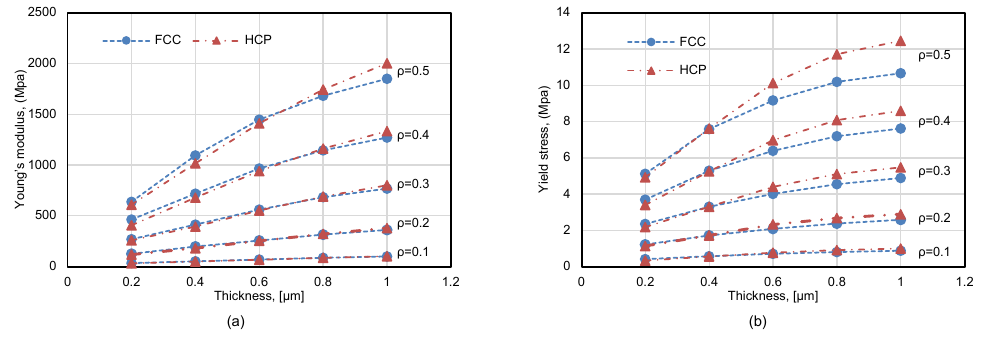
Figure 7. Dependence of Young’s modulus ( a ) and yield stress ( b ) of Au foams on thickness, including the variation with the type of sphere-packing and the relative density of the